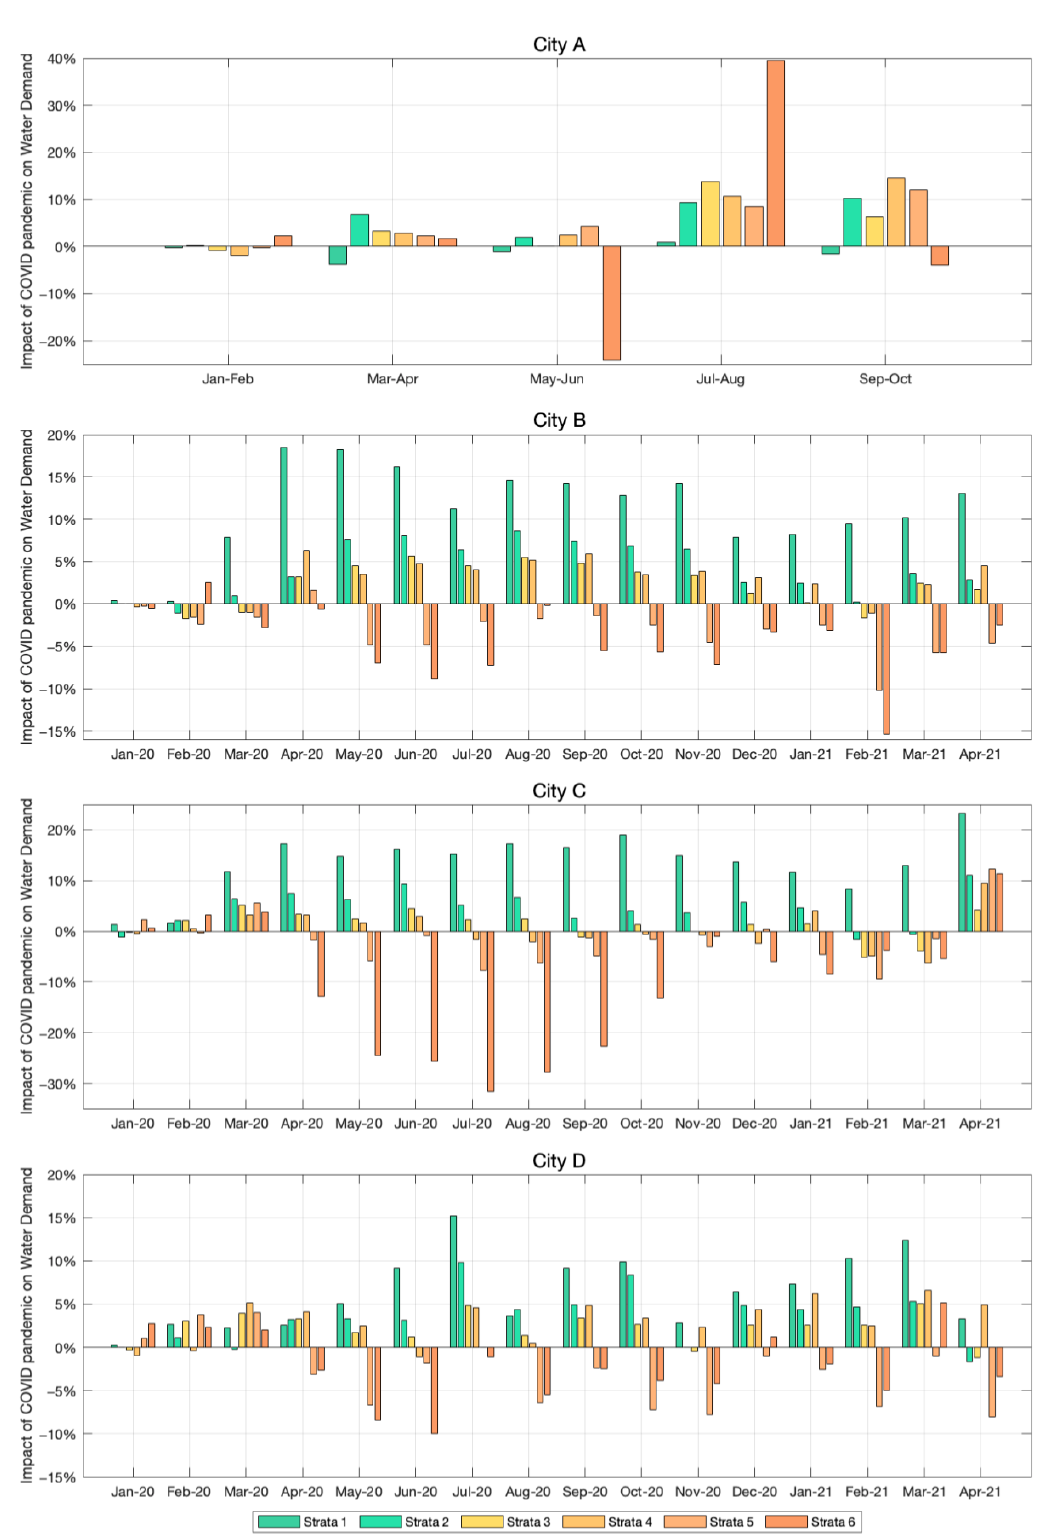
Figure 4. Difference between normal and estimated COVID-19 pandemic domestic water consump- tion by socioeconomic